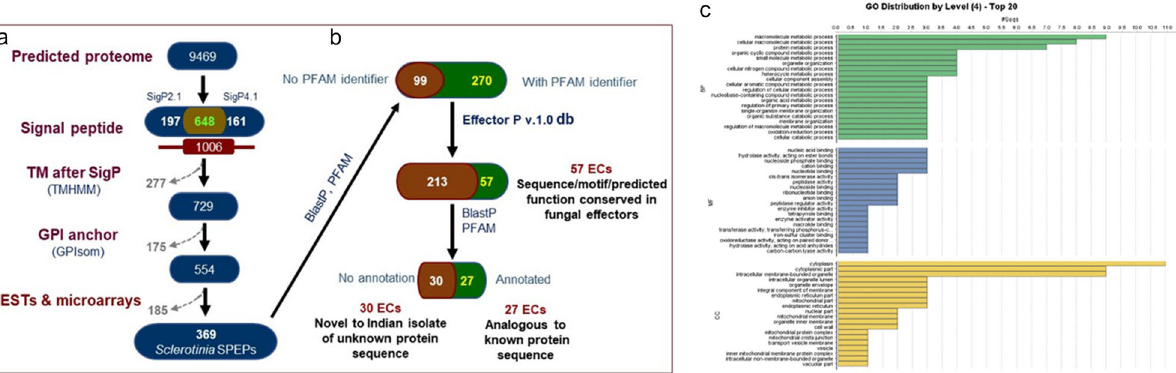
Figure 4. S. sclerotiorum secretome prediction, effector identification, and WEGO plot depicting the distribution of the top 27 hits of the predicted effector proteins ( a ) Out of the 554 predicted secreted proteins, 369 had experimental evidence for expression in planta ( S. sclerotiorum secreted proteins expressed in planta , SPEPs). The number of proteins filtered out is indicated with dotted arrows, the number of selected proteins is given within boxes, bioinformatics tools and resources used are indicated by the boxes ( b ) identification of effector candidates (ECs) based on sequence, motifs, or protein domains conserved in fungal effectors, and ( c ) The results are summarized in three main GO categories, cellular components (CC), molecular function (MF) and biological processes (BP). The left y-axis indicates the percentage of a specific category of genes in that main